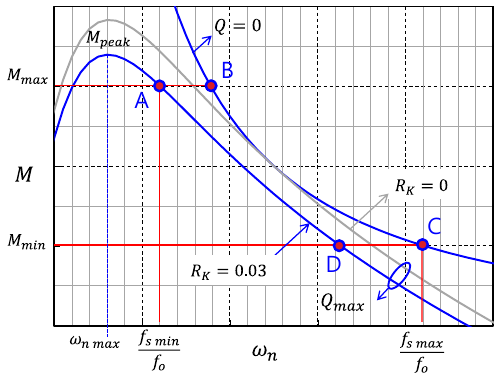
Figure 11. Characteristic graph of peak DC voltage gain M : ( a ) Peak DC voltage gain M vs. normal- ized frequency 𝜔 𝑛 ; ( b ) Q vs. Normalized frequency 𝜔 𝑛 ; ( c ) DC voltage gain M in accordance with